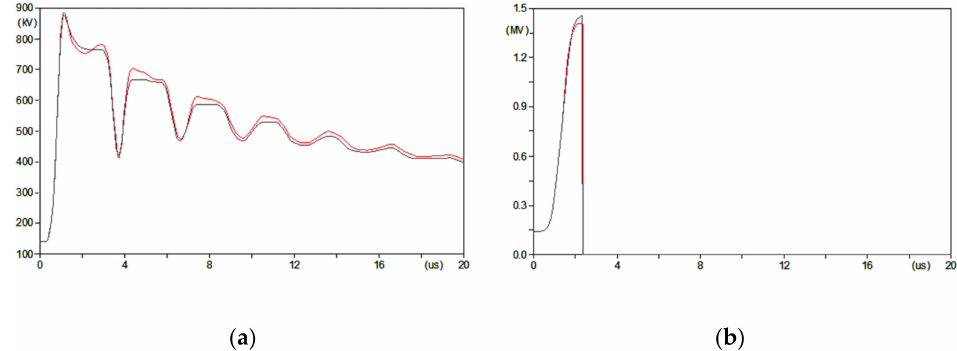
Figure 10. Voltage across insulator (most stressed phase) against time when a 150 kV OHL equipped with MT6 grounding arrangement is struck by lightning. Red line: full circuit model; black line: pi-circuit model. ( a ) ρ g = 2000 Ω · m, I P = 35 kA, t F = 1.19 µ s, t H = 300 µ s; ( b ) ρ g = 2000 Ω · m, I P = 75 kA, t F = 1.96 µ s, t H = 300 µ s.